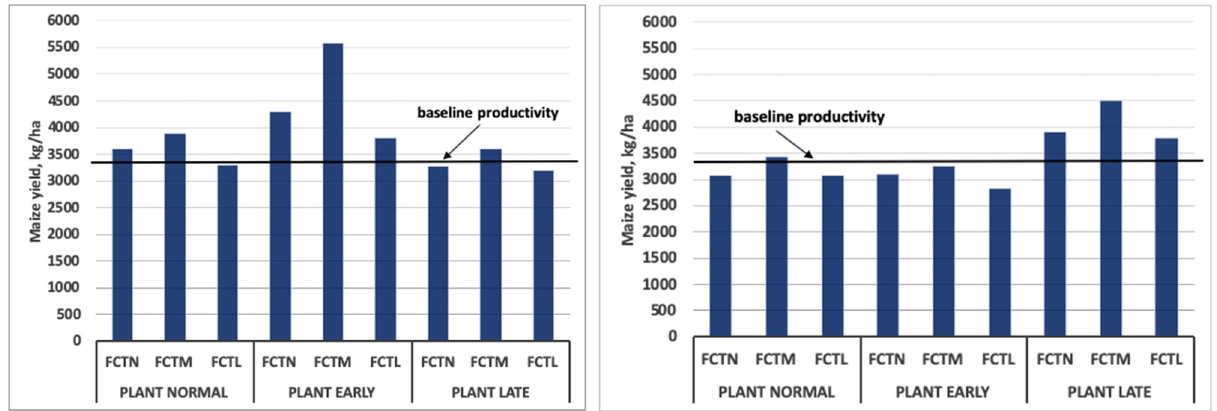
Figure 6. Crop yield under different farming activities and more/less rainfall conditions.